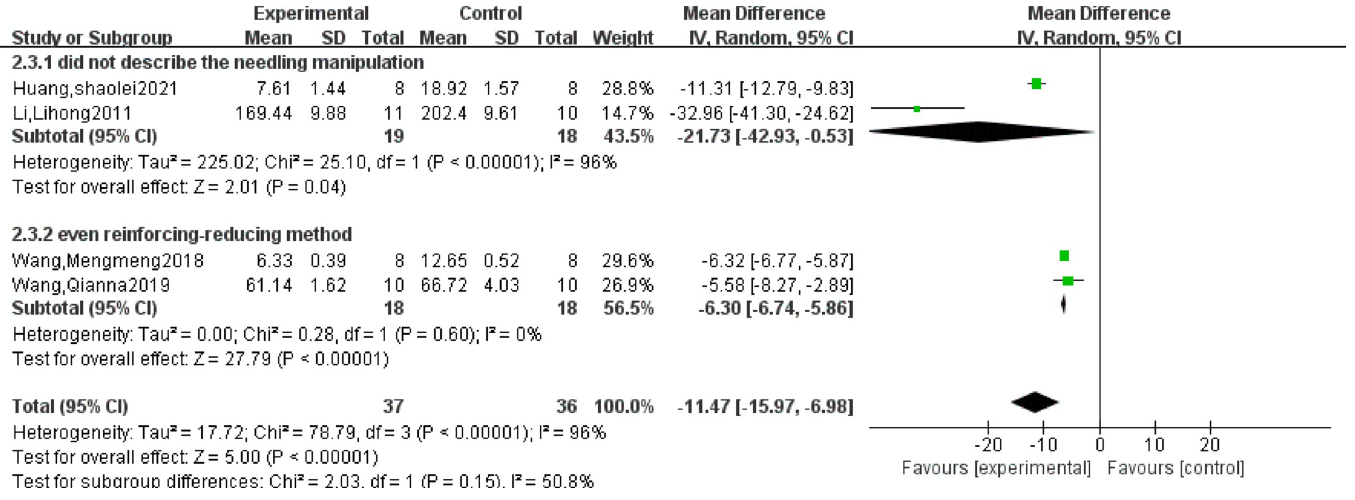
Fig 3. Subgroup analysis of SP.